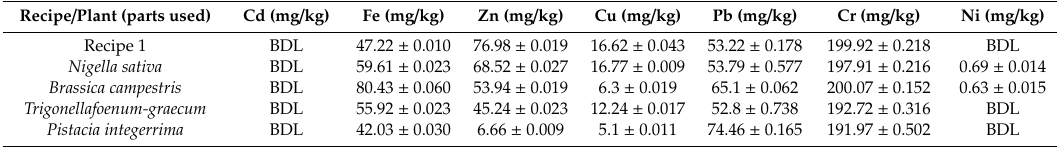
Table 3. Heavy Metals in Individual Plants and Its Recipe 1.